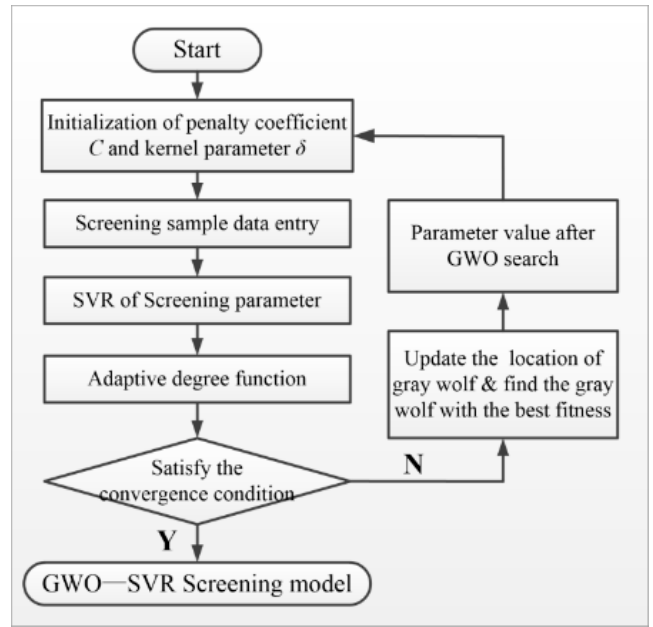
Figure 9. Work fl ow fi r the GWO-SVR. Figure 9. Workflow fir the